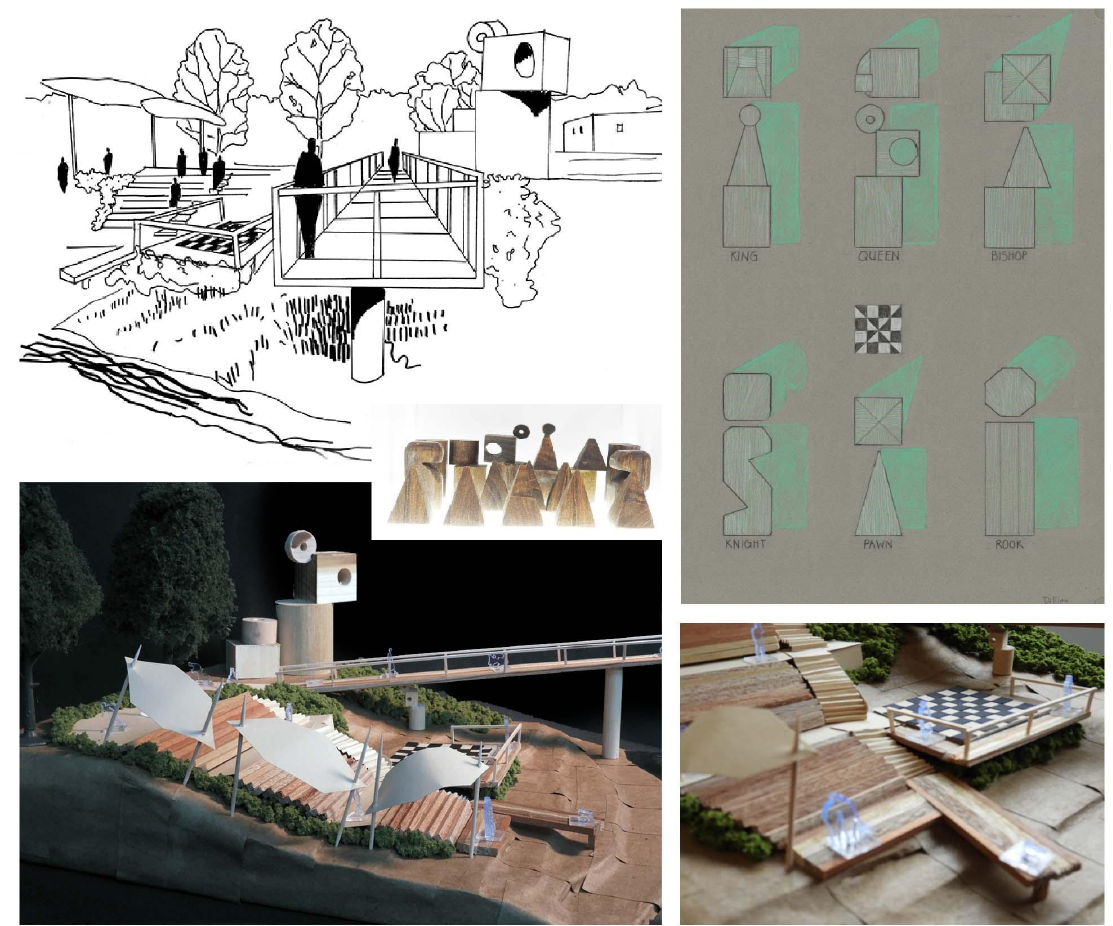
An example of one student’s semester work informed by the concept of catena, or a series of connected activities. The queen piece from a designed chess set emerges into a landmark sculpture overlooking two jetties, a seating area and an outdoor chess play deck (Source: Work by Dillon Redding, photographs by Authors,